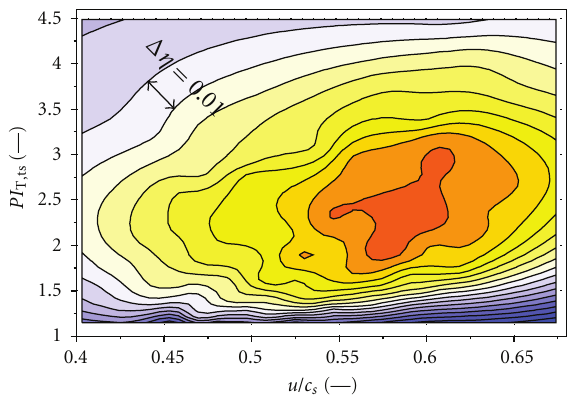
Figure 12: Mixed flow turbine e ffi ciency contour plot